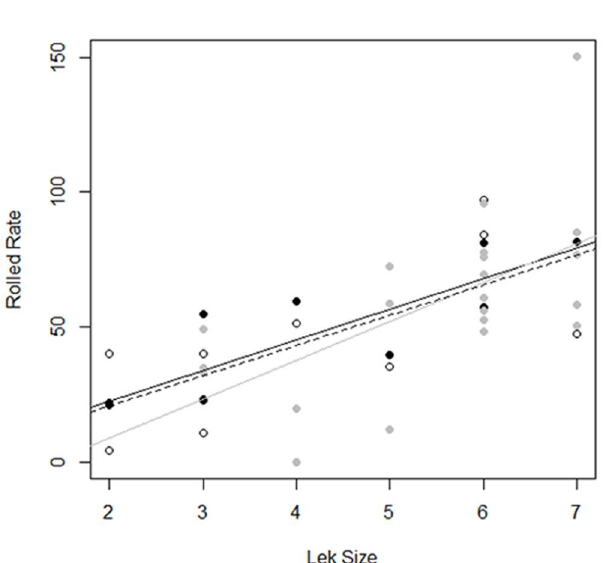
Fig 6. Rolled snap rate (#/h,RS) for lowest(whitecircles), intermediate (gray circles), and highest ranking(black circles) M . manacus males on leks of differentsizes(LS). Best fit straightlines were indicated for lowest (dashedline; RS = –1.45 + 11.17 * LS;r 2 = 0.42,F = 7.56,p = 0.02),intermediate (gray line; RS = –19.82+ 14.38 * LS;r 2 = 0.34,F = 11.51,p = 0.003),and highest (black line; RS = –0.4 + 11.38 * LS; r 2 = 0.68,F = 20.52,p = 0.002)ranking males.